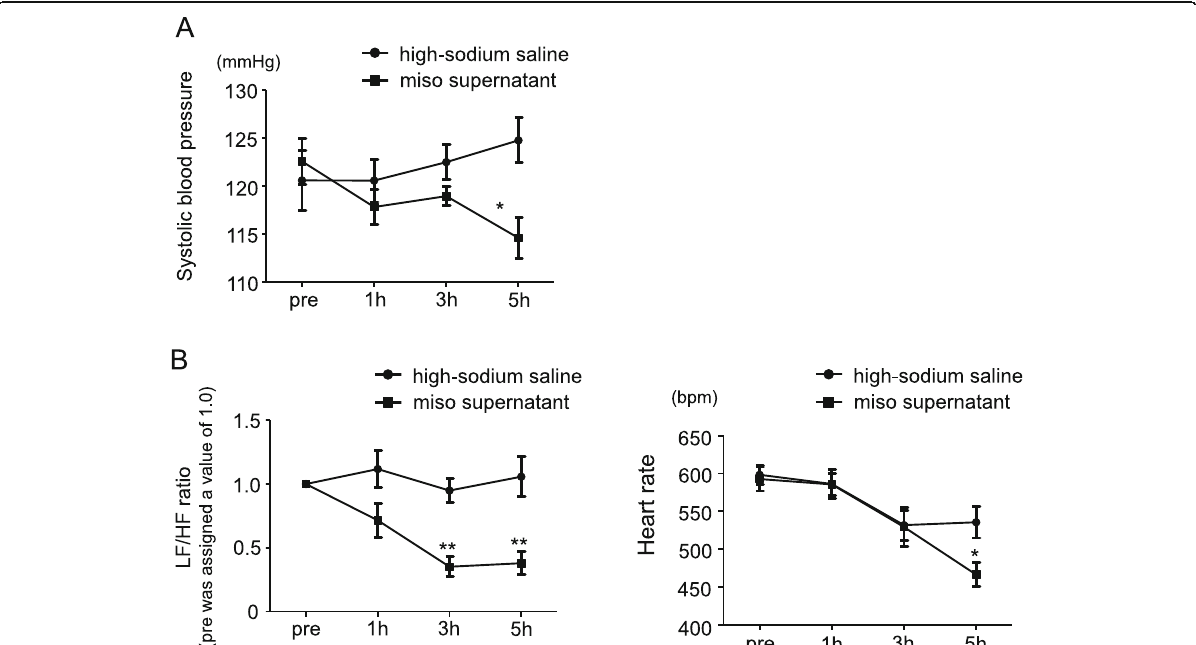
Fig. 4 a Systolic blood pressure in normal mice after IP injection of high-sodium saline or miso supernatant. n = 5 for each. * p < 0.05 high- sodium saline versus miso supernatant. b LF/HF ratio (left) and heart rate (right) in normal mice evaluated via ECG. The LF/HF ratio before the injection was assigned a value of 1.0. n = 9 for each. * p < 0.05, ** p < 0.01 high-sodium saline versus miso supernatant. IP, intraperitoneal; LF, low frequency power of heart rate variability; HF, high frequency power of heart rate